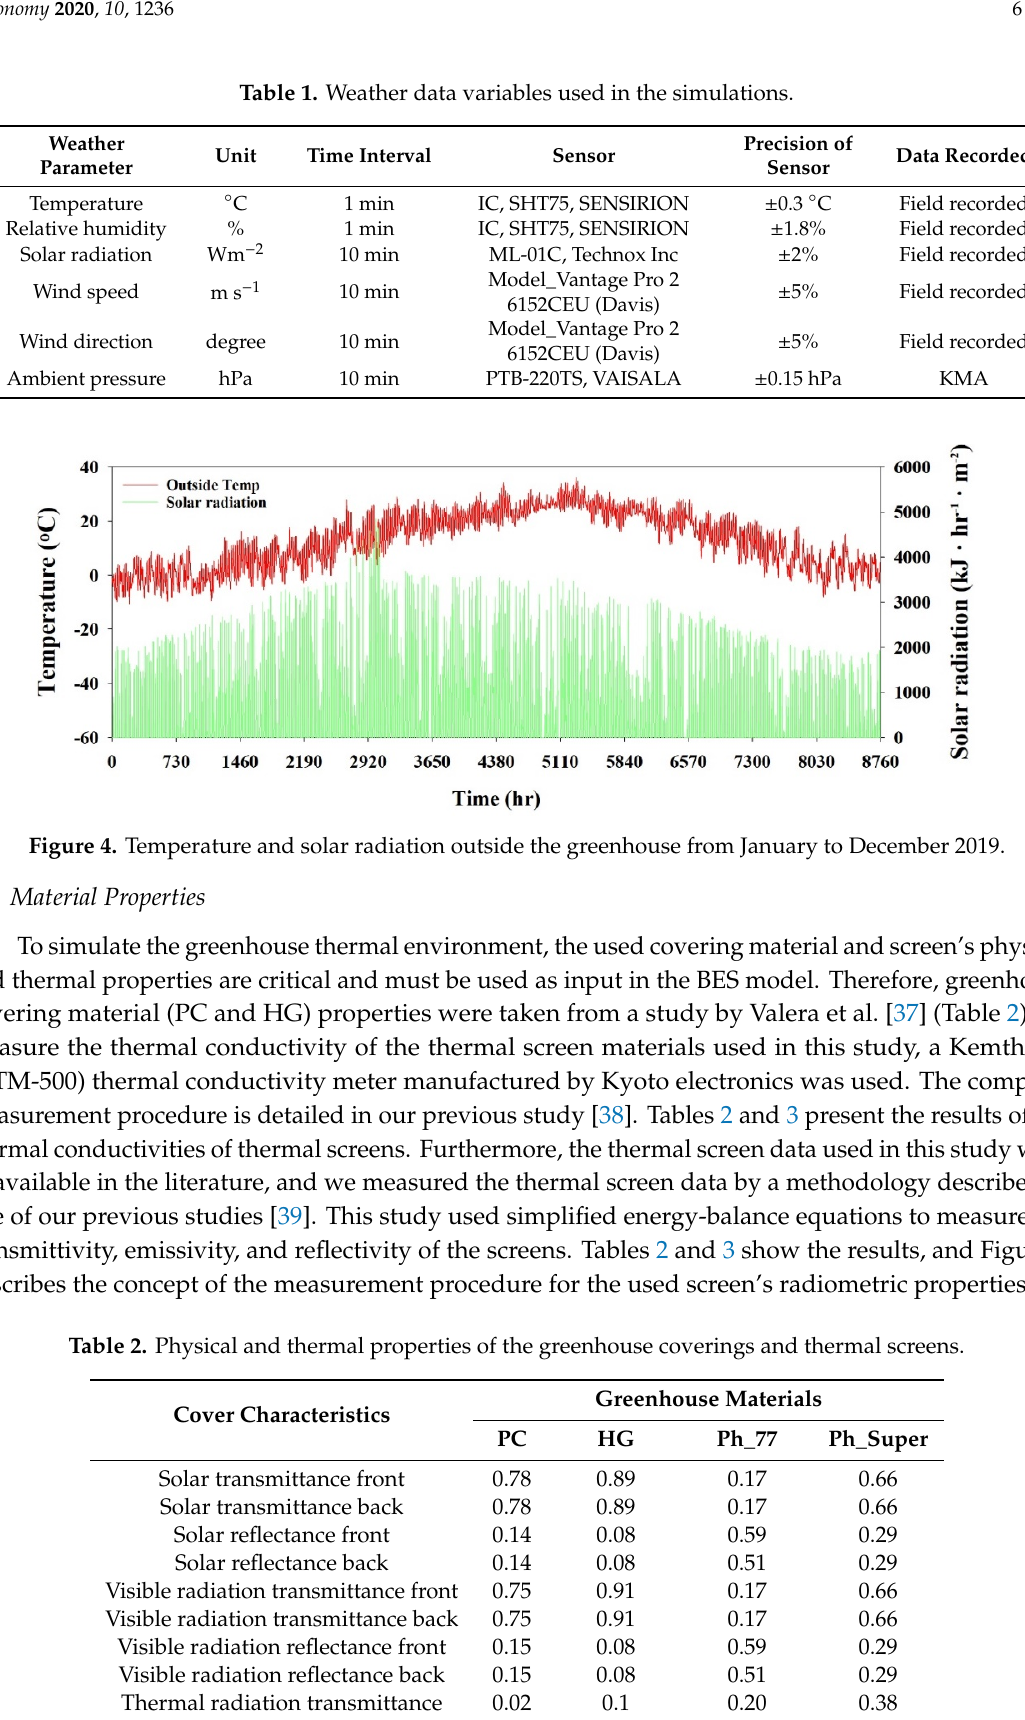
Table 1. Weather data variables used in the simulations.